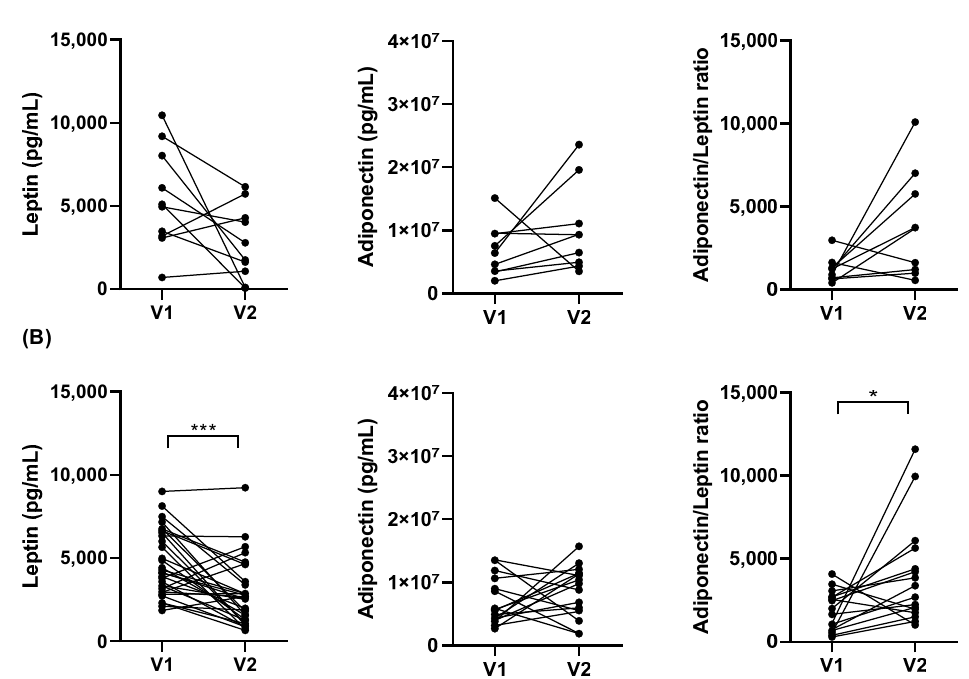
Figure 2. Serum leptin, adiponectin, and adiponectin/leptin ratio values from obese asthmatics ( A ) and obese subjects ( B ) before (V1) and after (V2) bariatric surgery. Data presented as individual values. * p < 0.05, *** p ≤ 0.001; Wilcoxon test for paired data comparisons between V1 and V2. 3.2. Comparison of Serum Inflammatory Markers between HC and the NOA, OA and O Groups The circulating concentration levels of six molecular products: TGF- β 1, TNFR2, MCP-1, ezrin, YKL-40, and ST2 were found to be significantly higher in O subjects with respect to HC. The OA group also showed significantly increased levels of four products compared with HC: MCP-1, ezrin, YKL-40, and IL-18. Finally, in the serum of NOA indi- viduals, four molecular products also had significantly higher concentrations compared with HC: ezrin, YKL-40, IL-5, and IL-18 (Table 3). Table 3. Serum cytokine level comparison of non-obese asthmatics, obese asthmatics, and obese subjects with healthy controls. HC